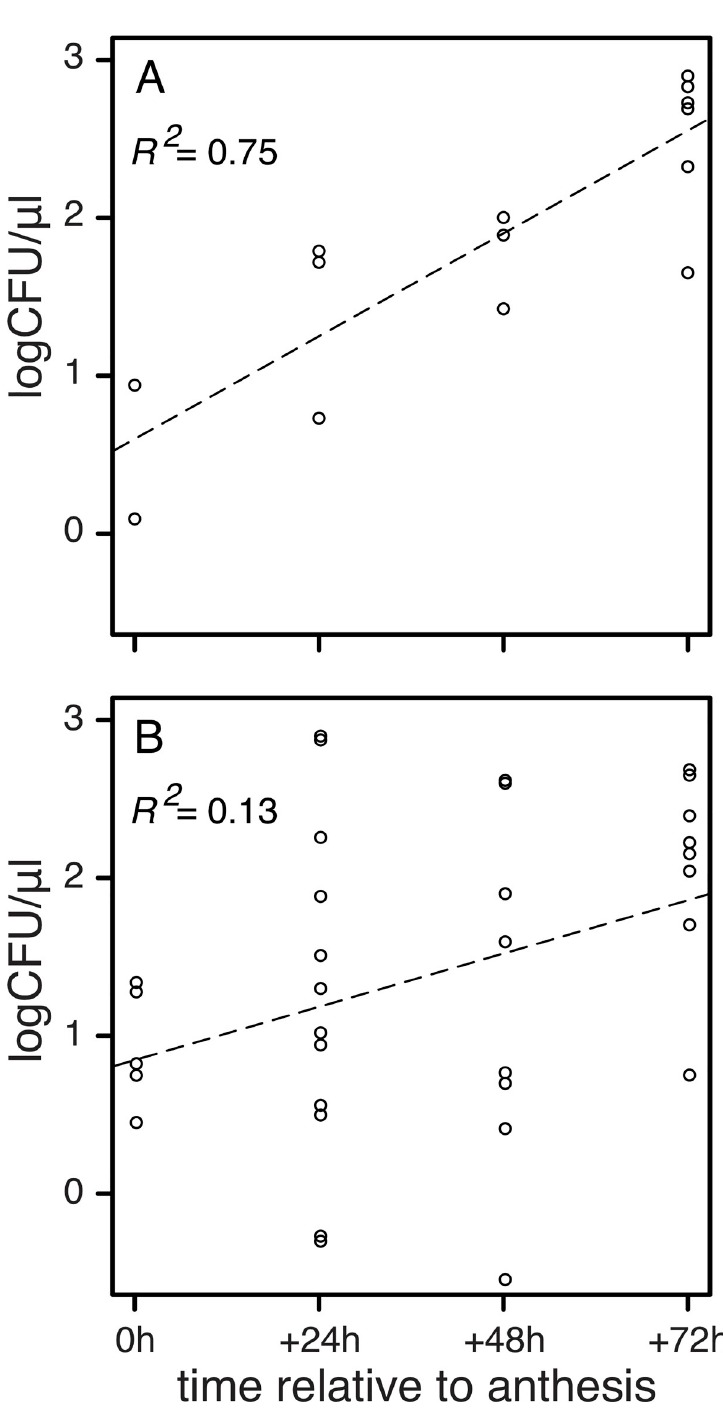
Fig 4. Concentration of colony forming units in A . palmeri nectar. (A) CFU concentration in the nectar of 0, 1, 2, and 3 d old A . palmeri flowers with flower visitor exclusion (N = 2, 3, 3, and 7, respectively). (B) CFU concentration in the nectar of 0, 1, 2, and 3 d old A . palmeri flowers without flower visitor exclusion (N = 5, 12, 8, and 8,